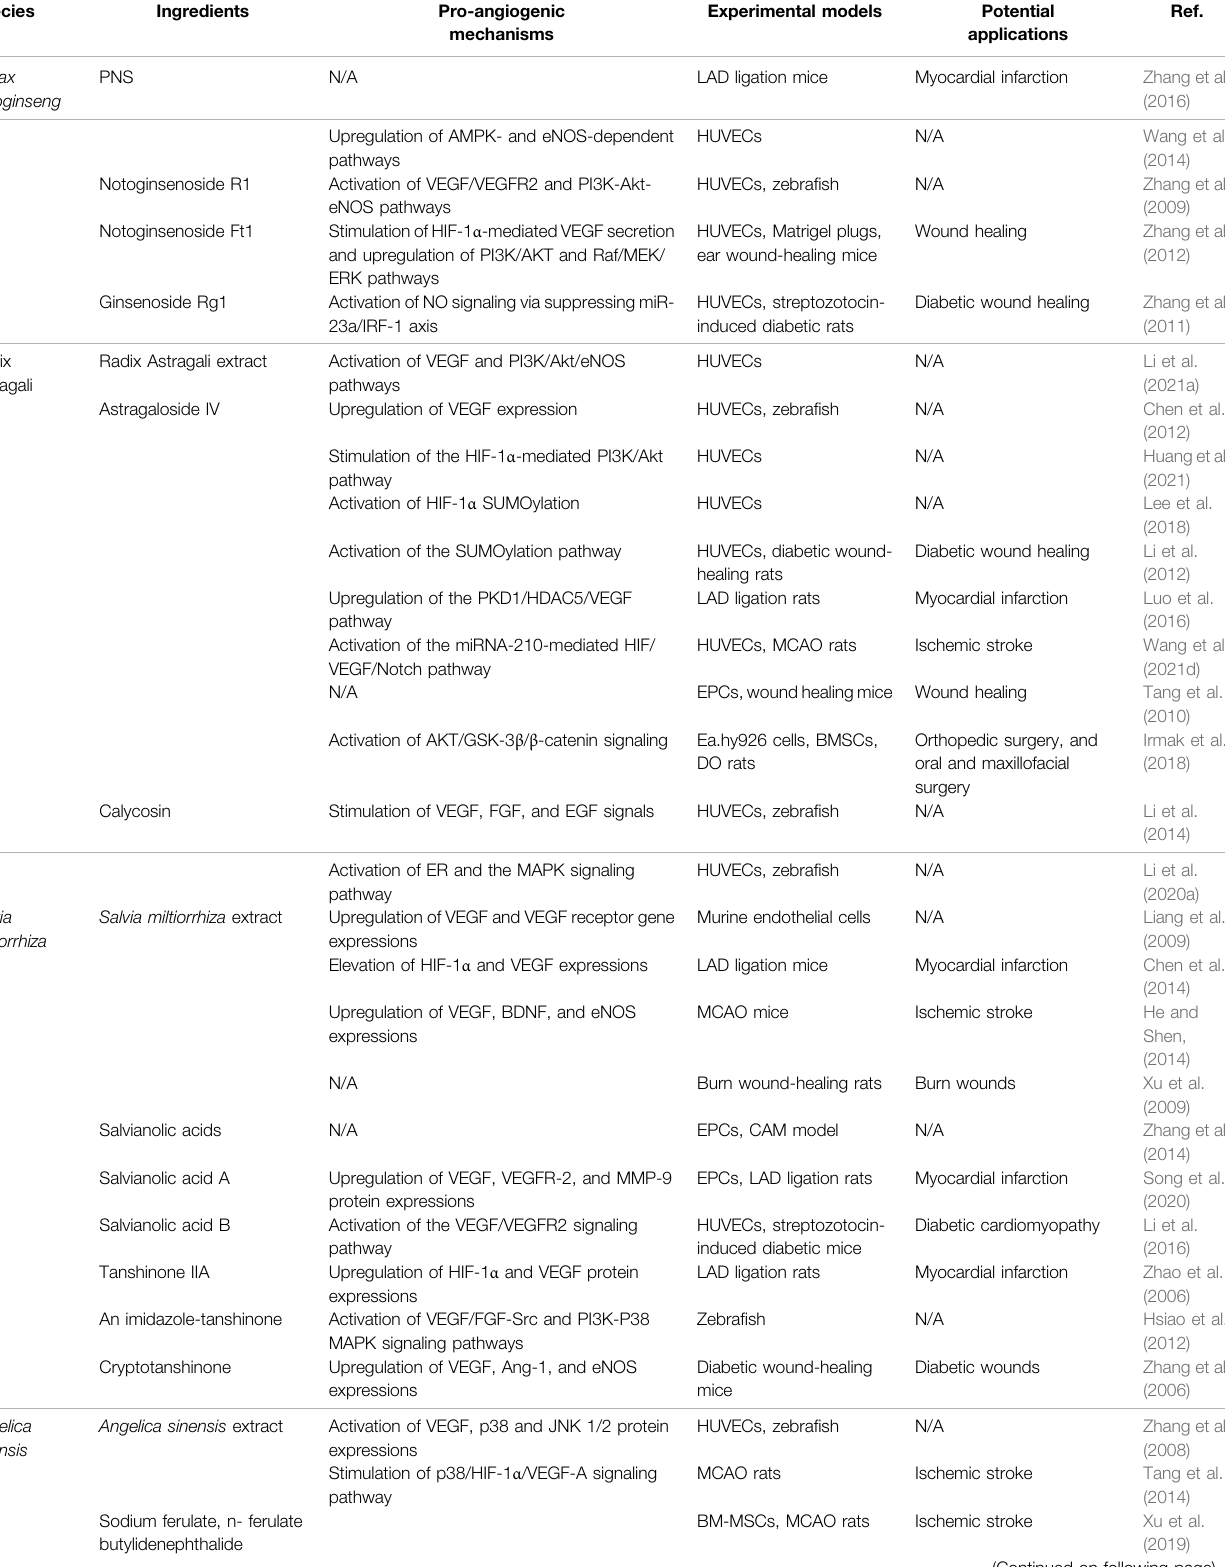
TABLE 3 | Summary of pro-angiogenic phytochemicals and their potential applications.